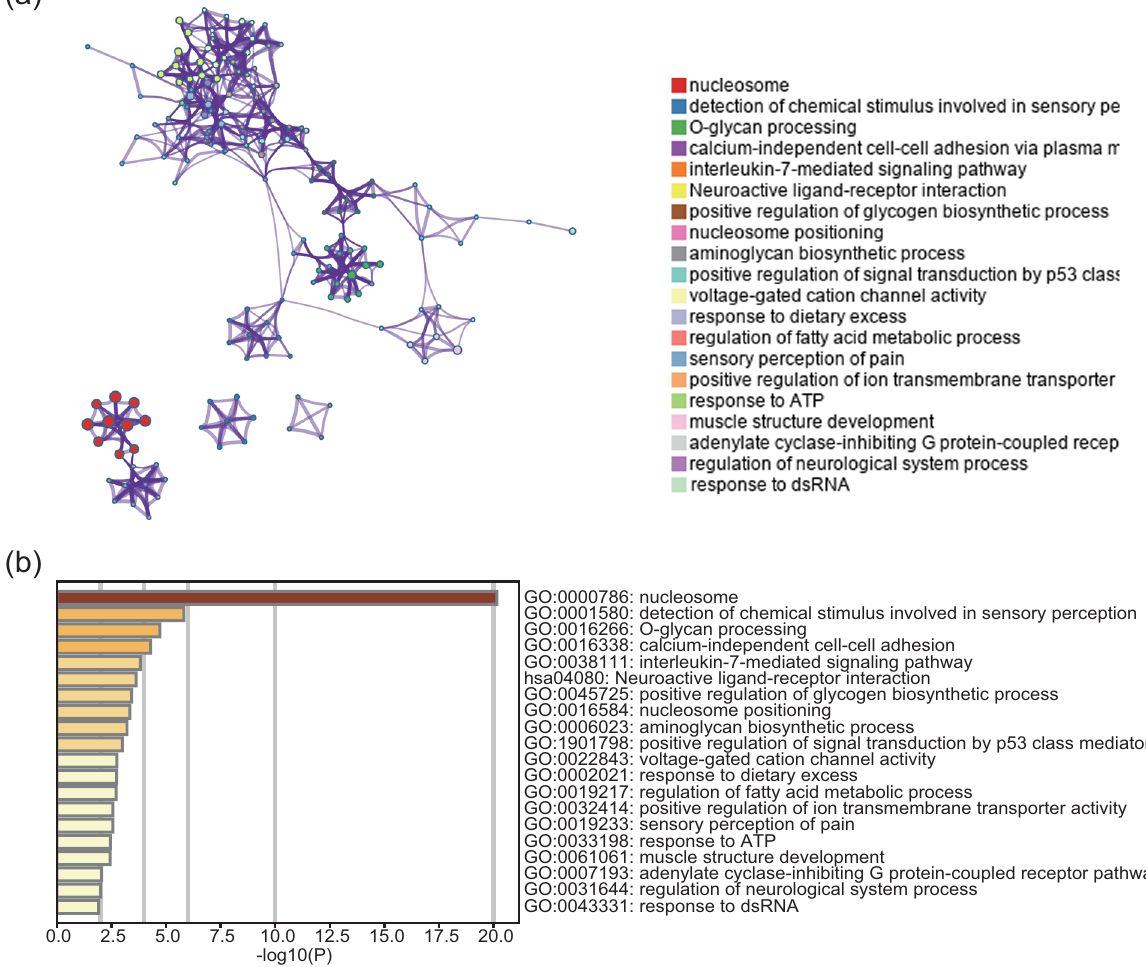
Figure 7: Functional enrichment results of the co - expressed protein - coding genes with four lncRNAs. ( a ) Signi fi cantly enriched pathways of the 232 correlated genes. ( b ) Functional enrichment diagram of the pathway. Each node represents a GO item. Node size represents the number of genes in the pathway.